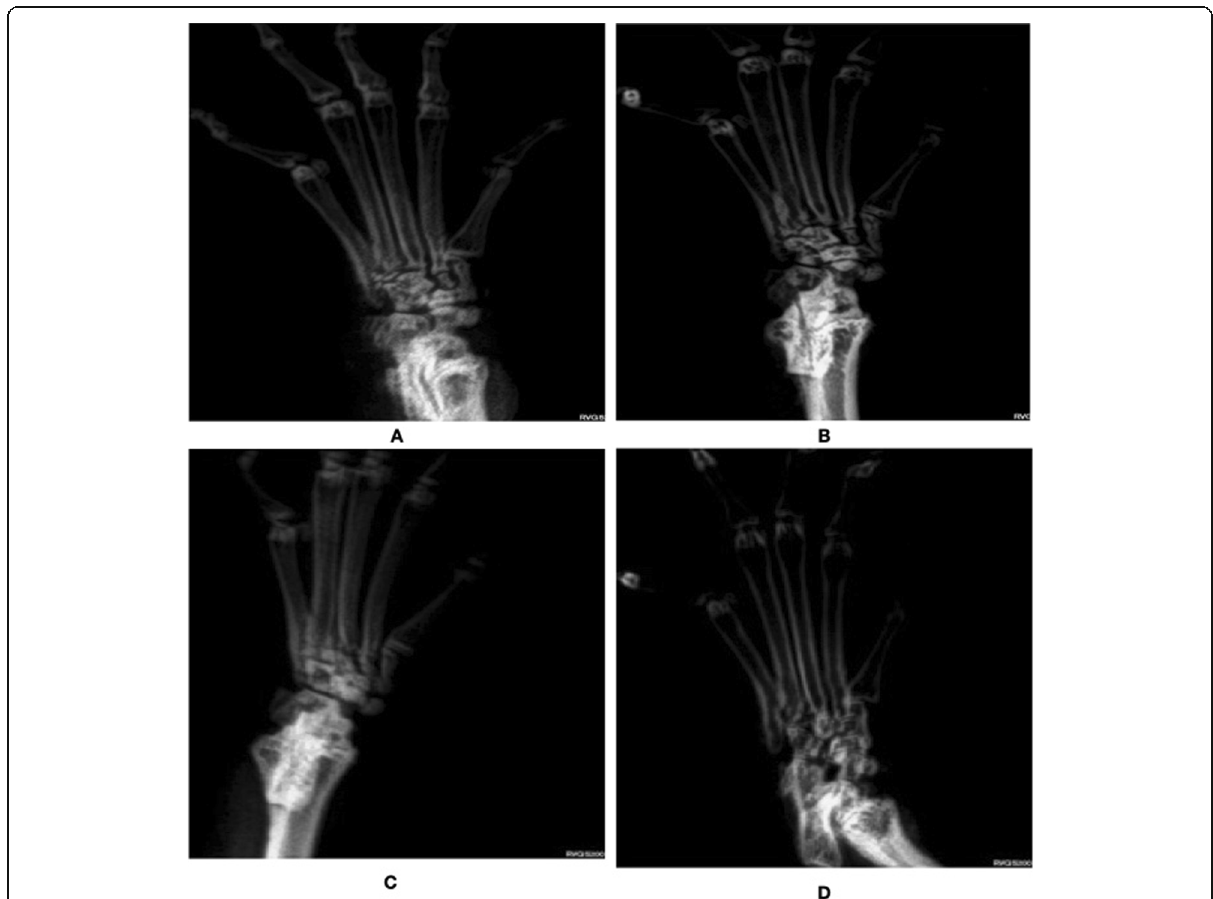
Fig. 4 X-ray images of CFA induced paw edema in rats. a = Control group, b = Low dose group (200 mg/kg), c = High dose group (400 mg/kg), d =